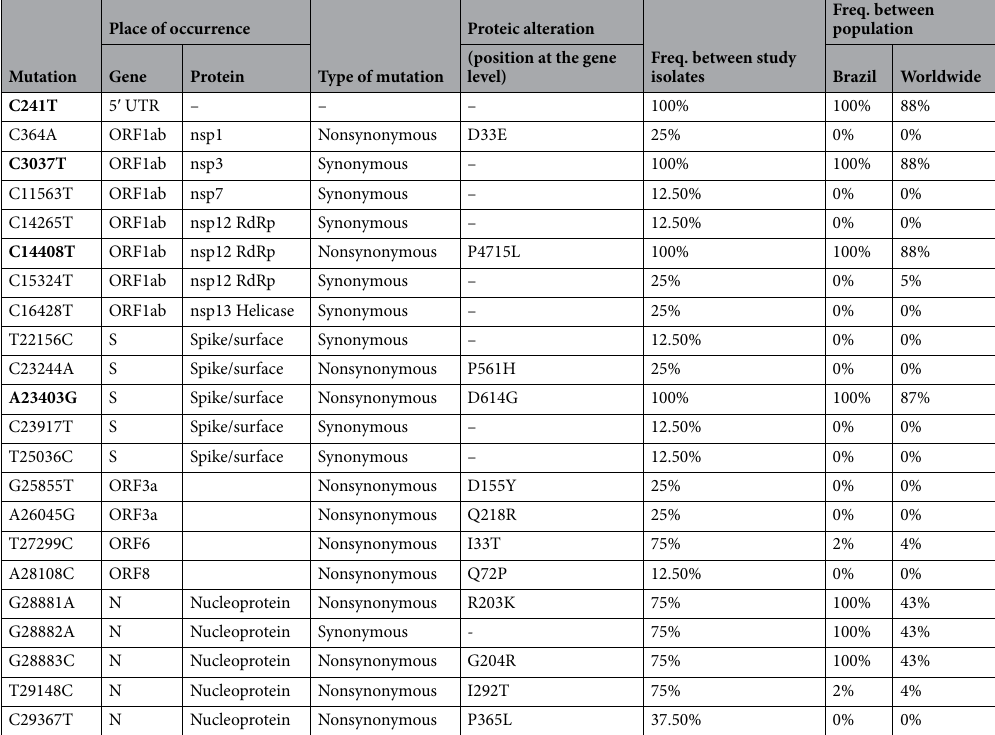
Table 1. Mutations found in strains of SARS-CoV-2 isolated in